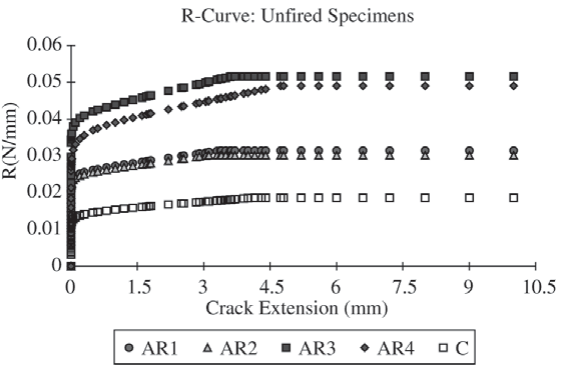
Figure 4. R-Curve for fired (1000 °C/4 h) specimens of different compositions and coarse aggregate aspect ratios.